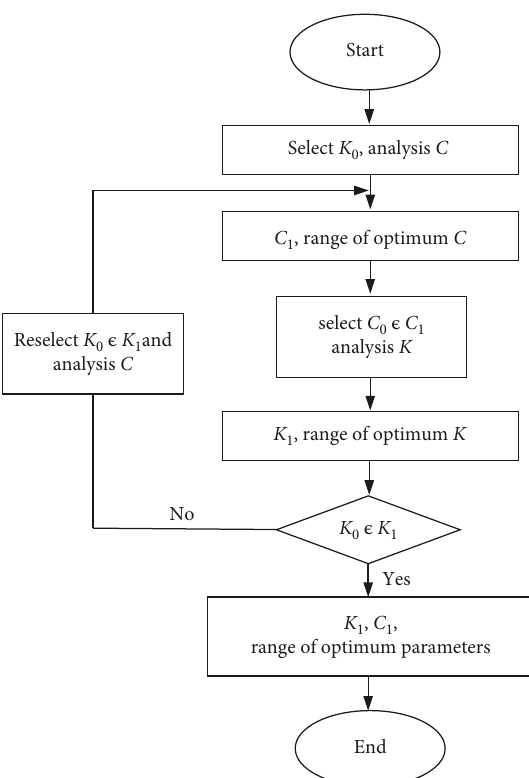
Figure 3: Procedure for selecting optimum parameters of anticollision